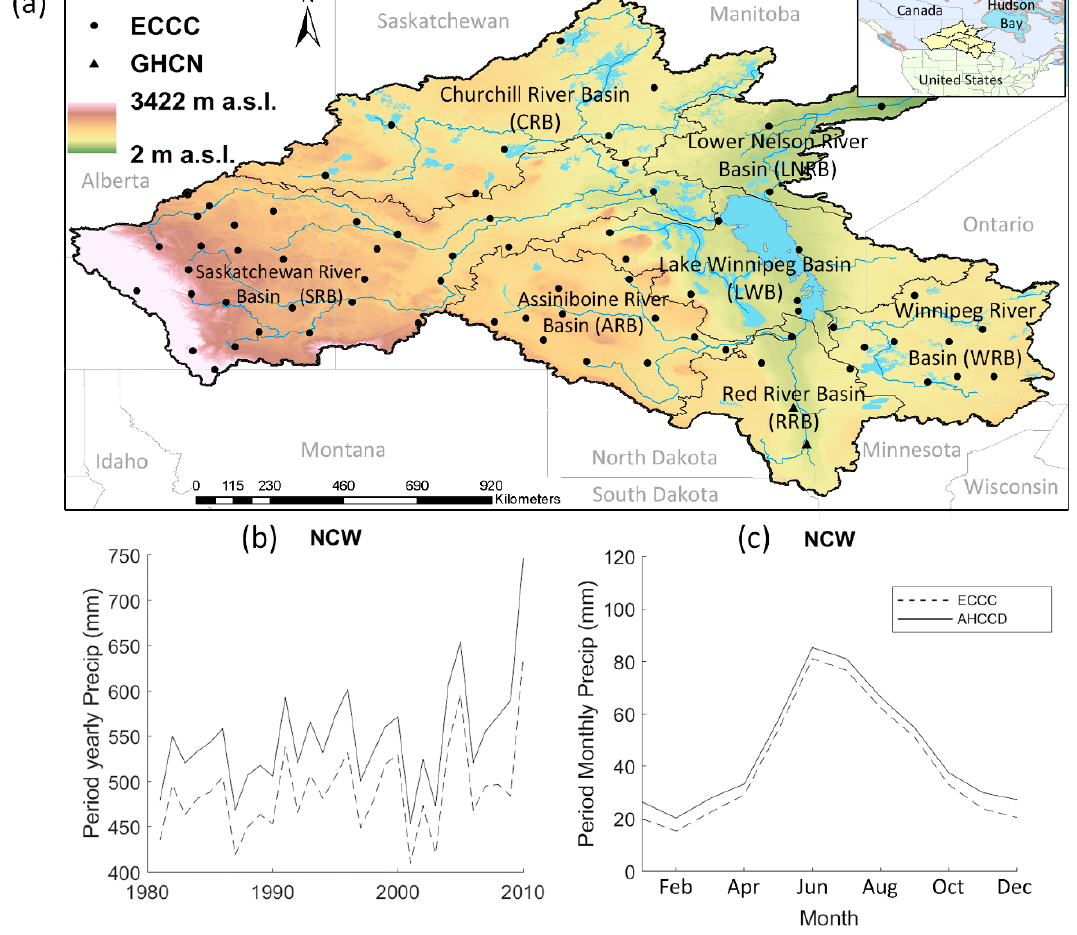
Figure 1. ( a ) Map of the Nelson–Churchill Watershed, including sub-basin delineations and 73 selected ground-based station locations. All Environment and Climate Change Canada (ECCC) stations also have a corresponding Adjusted and Homogenized Climate Change Data (AHCCD) station at the same location. ( b ) Spatially averaged yearly total precipitation timeseries, including all stations shown in ( a ). ( c ) Mean monthly precipitation including all stations shown in ( a ) for 1981– 2010.